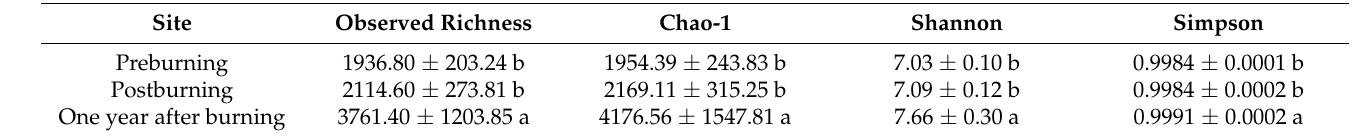
Table 3. Alpha diversity